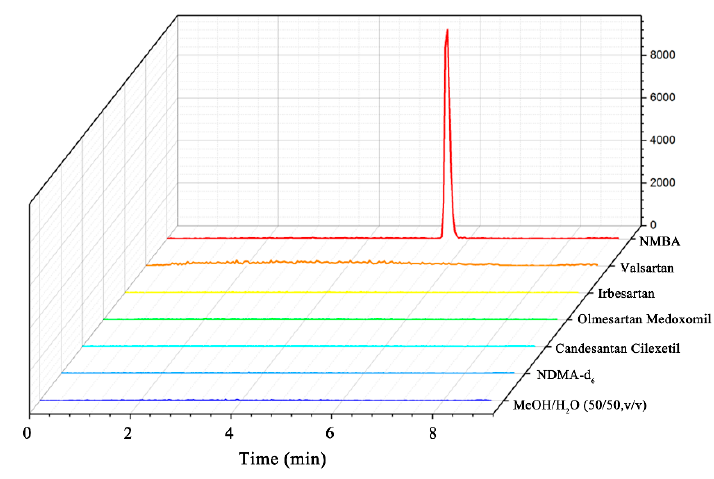
Figure 3. LC-MS/MS chromatograms of specificity for NMBA.